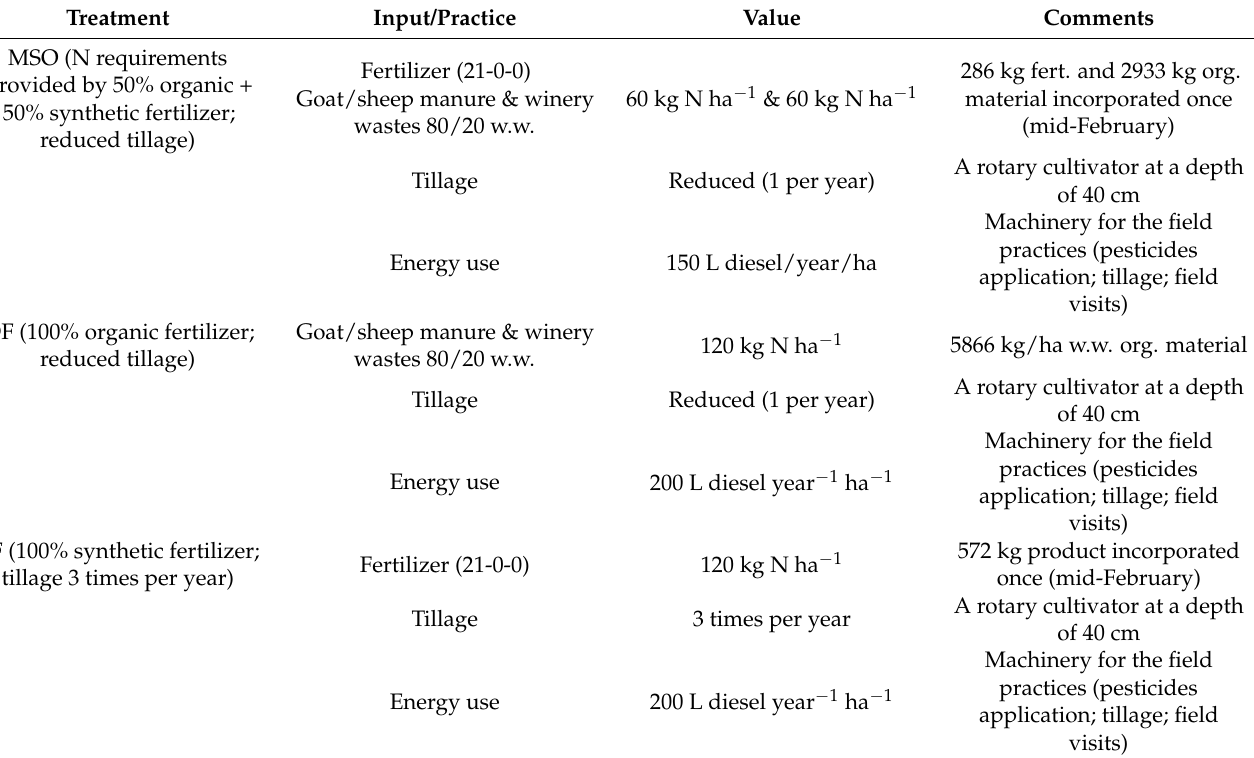
Table 1. Management practices for the 3 treatments. These data were used to run the